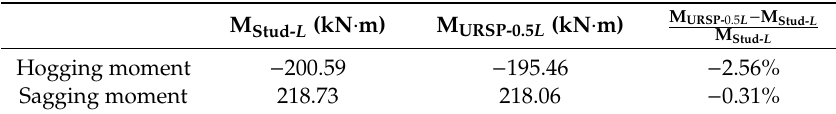
Table 3. The capacity of middle joints under load case 1.